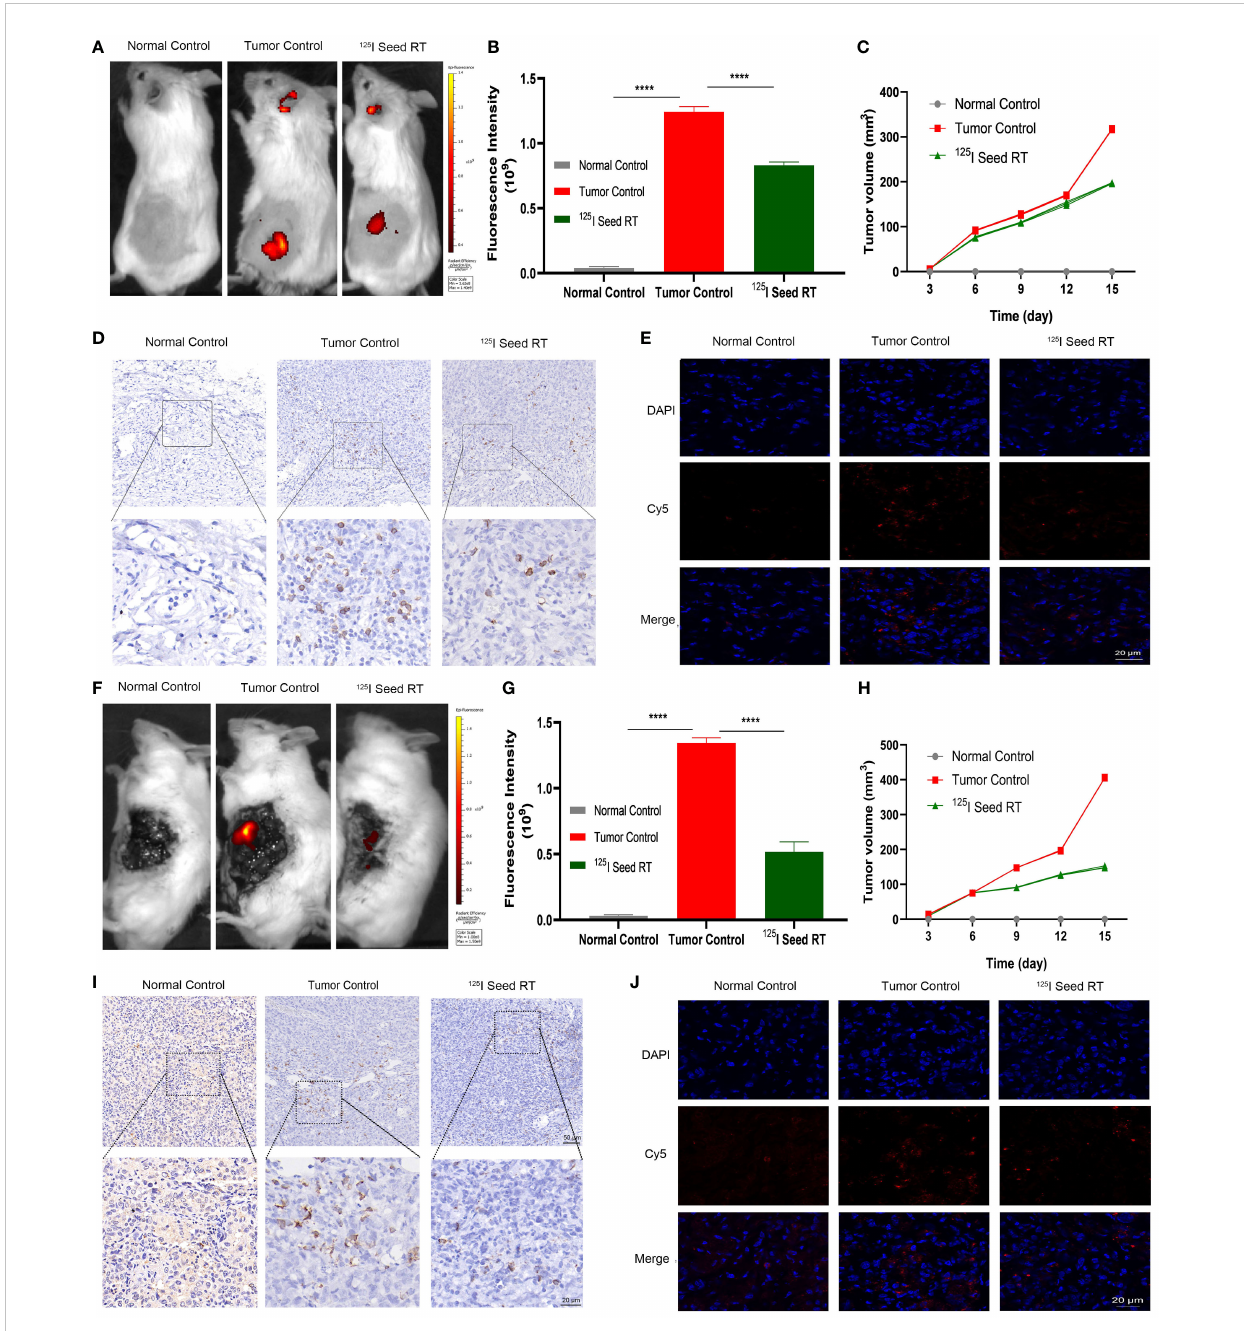
FIGURE 7 Fluorescence imaging in subcutaneous and orthotopic model of HCC. (A – F) Imaging of subcutaneous and orthotopic tumor after infusion of probes. (B – G) Quanti fi cation of FI in subcutaneous and orthotopic tumor (n=3). (D – I) IHC of TIGIT expression in subcutaneous and orthotopic tumor. (E – J) Probe distribution evaluated via IF staining of frozen sections from subcutaneous and orthotopic tumor. (C – H) Tumor volume of subcutaneous and orthotopic tumor after 125 I seed radiation (n=4). Scale bar: 50 m m. Scale bar: 20 m m. **** P <